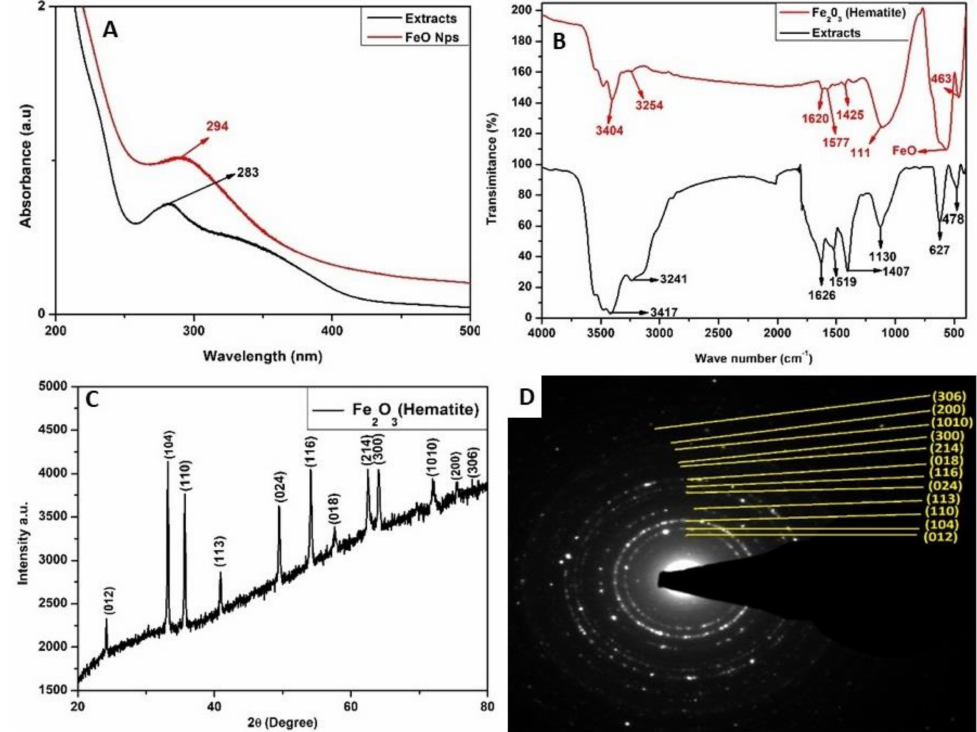
Figure 1. Plasmic resonance and structural characterization of green-synthesized hematite ( α Fe 2 O 3